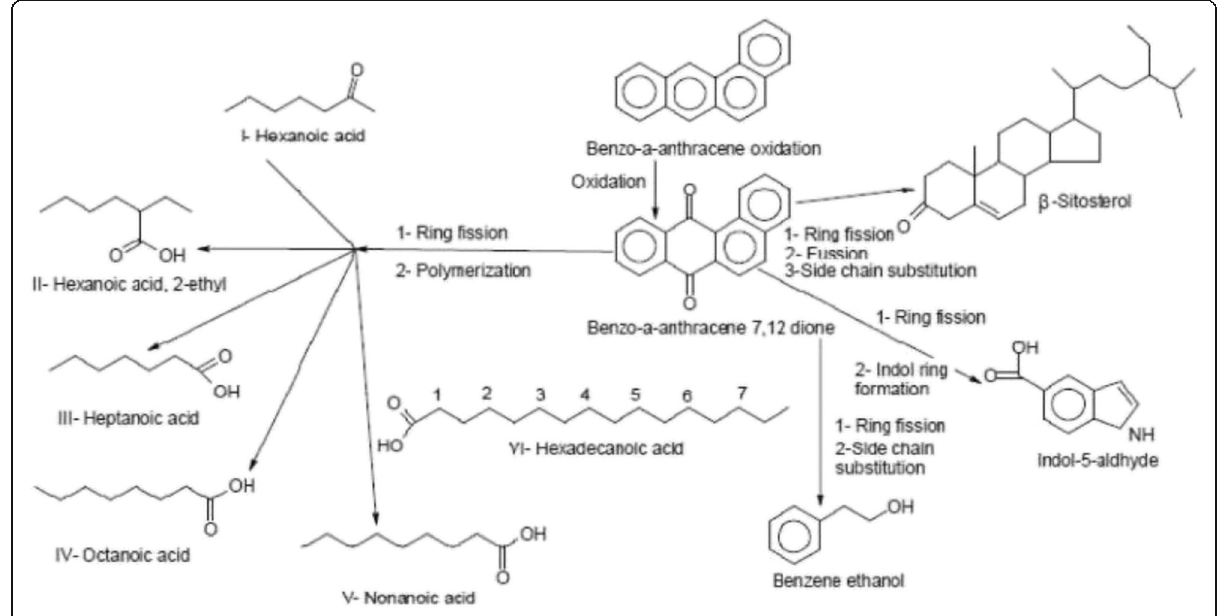
Fig. 1 Proposed pathway of benzo-a-anthracene degradation by B . amyloliquefaciens (Partila